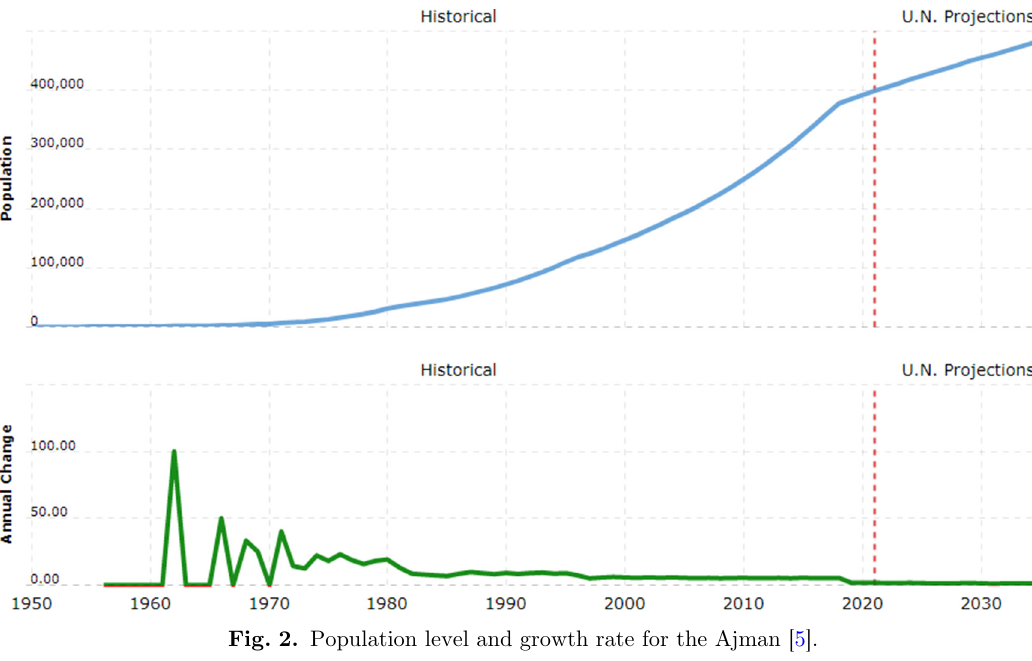
Fig. 2. Population level and growth rate for the Ajman [5].